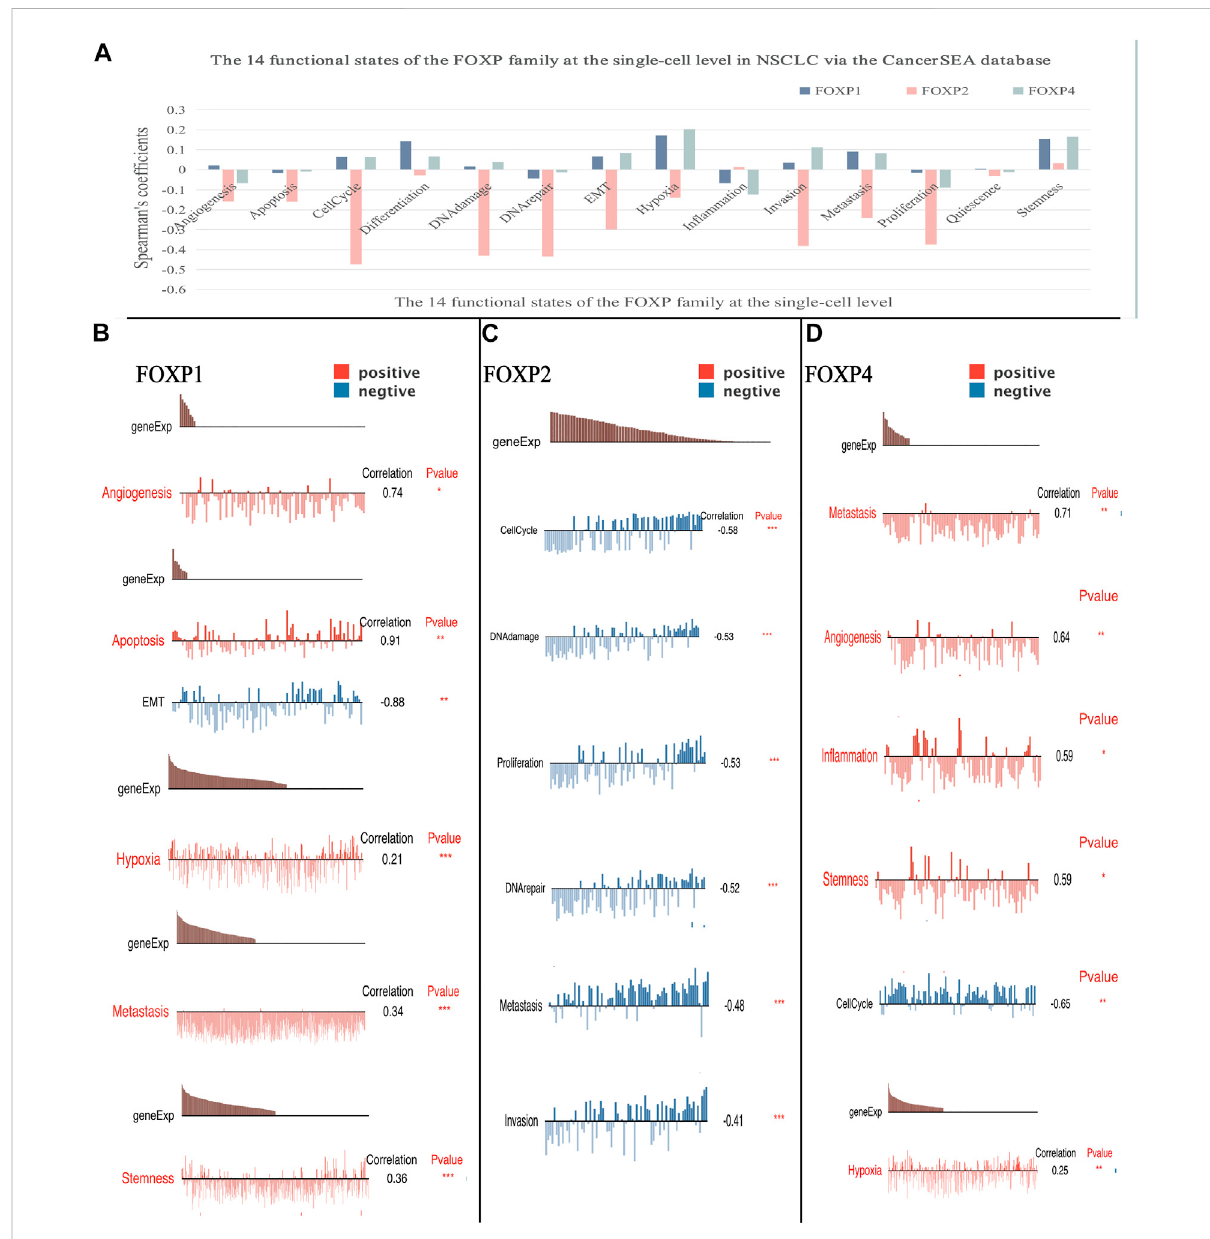
FIGURE 8 ThecorrelationbetweentheFOXPfamilyand14functionalstatesatsingle-celllevel. (A) Theresultofthecorrelationbetweenexpressionofthe FOXP1/2/4 with functional states (including angiogenesis, apoptosis, invasion, EMT, differentiation, proliferation, DNA damage, metastasis, hypoxia, in fl ammation, cell cycle, DNA repair, stemness, and quiescence). (B) The sample Kim (Exp0068) showed the result of the correlation between the FOXP1with functionalstates. (C) The sample Kim(Exp0066)showed theresultofthecorrelationbetween theFOXP2with functional states. (D)